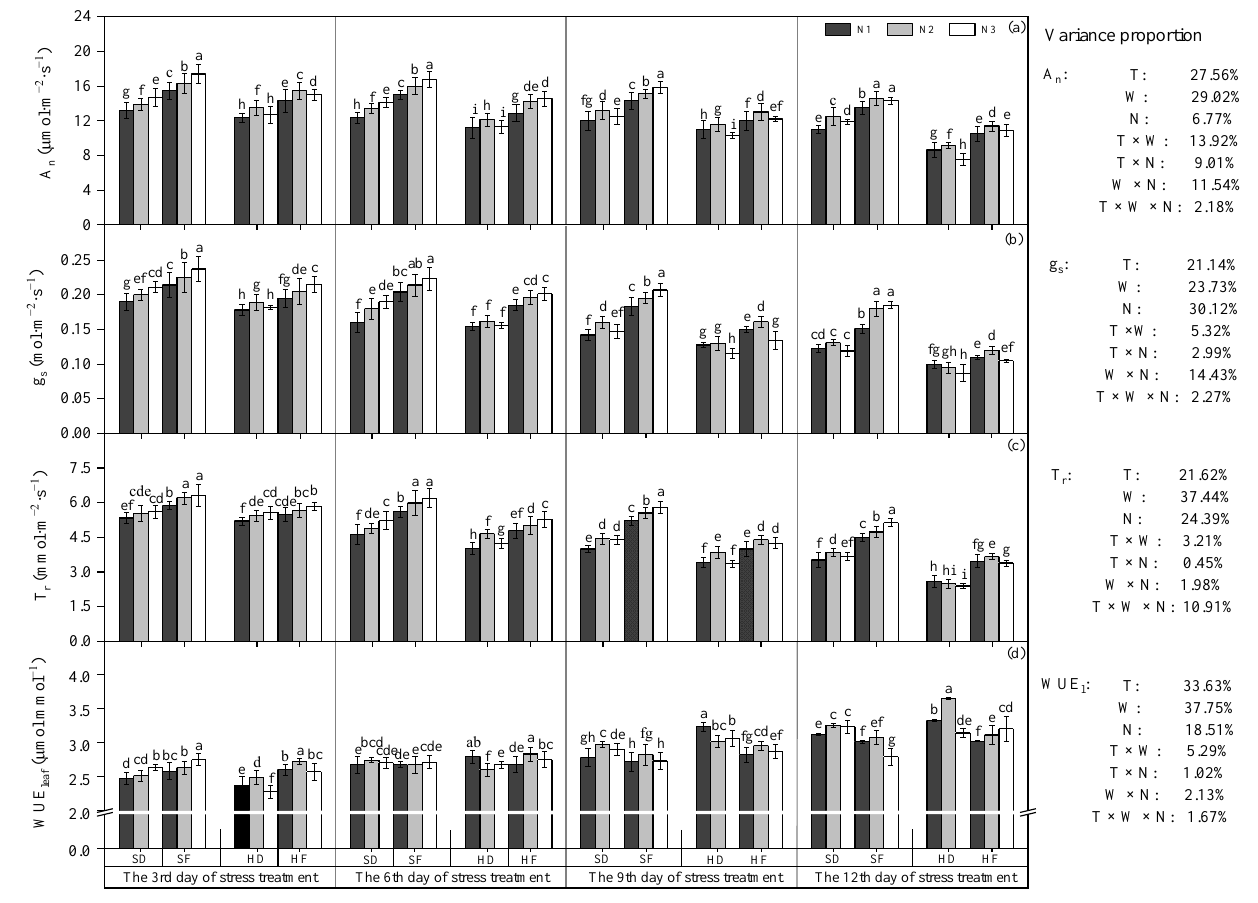
Figure 3. Effects of N application on net photosynthetic rate (A n , a ), stomatal conductance (g s , b ), transpiration rate (T r , c ) and instantaneous water use efficiency (WUE leaf , d ) in the leaves of wheat under short-term heat, drought and combined stress after anthesis. SD: suitable temperature + drought stress; HD: heat + drought stress; HF: heat stress + full watering; SF: suitable temperature + full watering. T: temperature; W: watering; N: nitrogen. The values are the means ± standard deviation, n = 10. Different lowercase letters indicate statistically significant differences ( p < 0.05). The right side of the figure shows the proportion of variance explained by each factor and interaction.